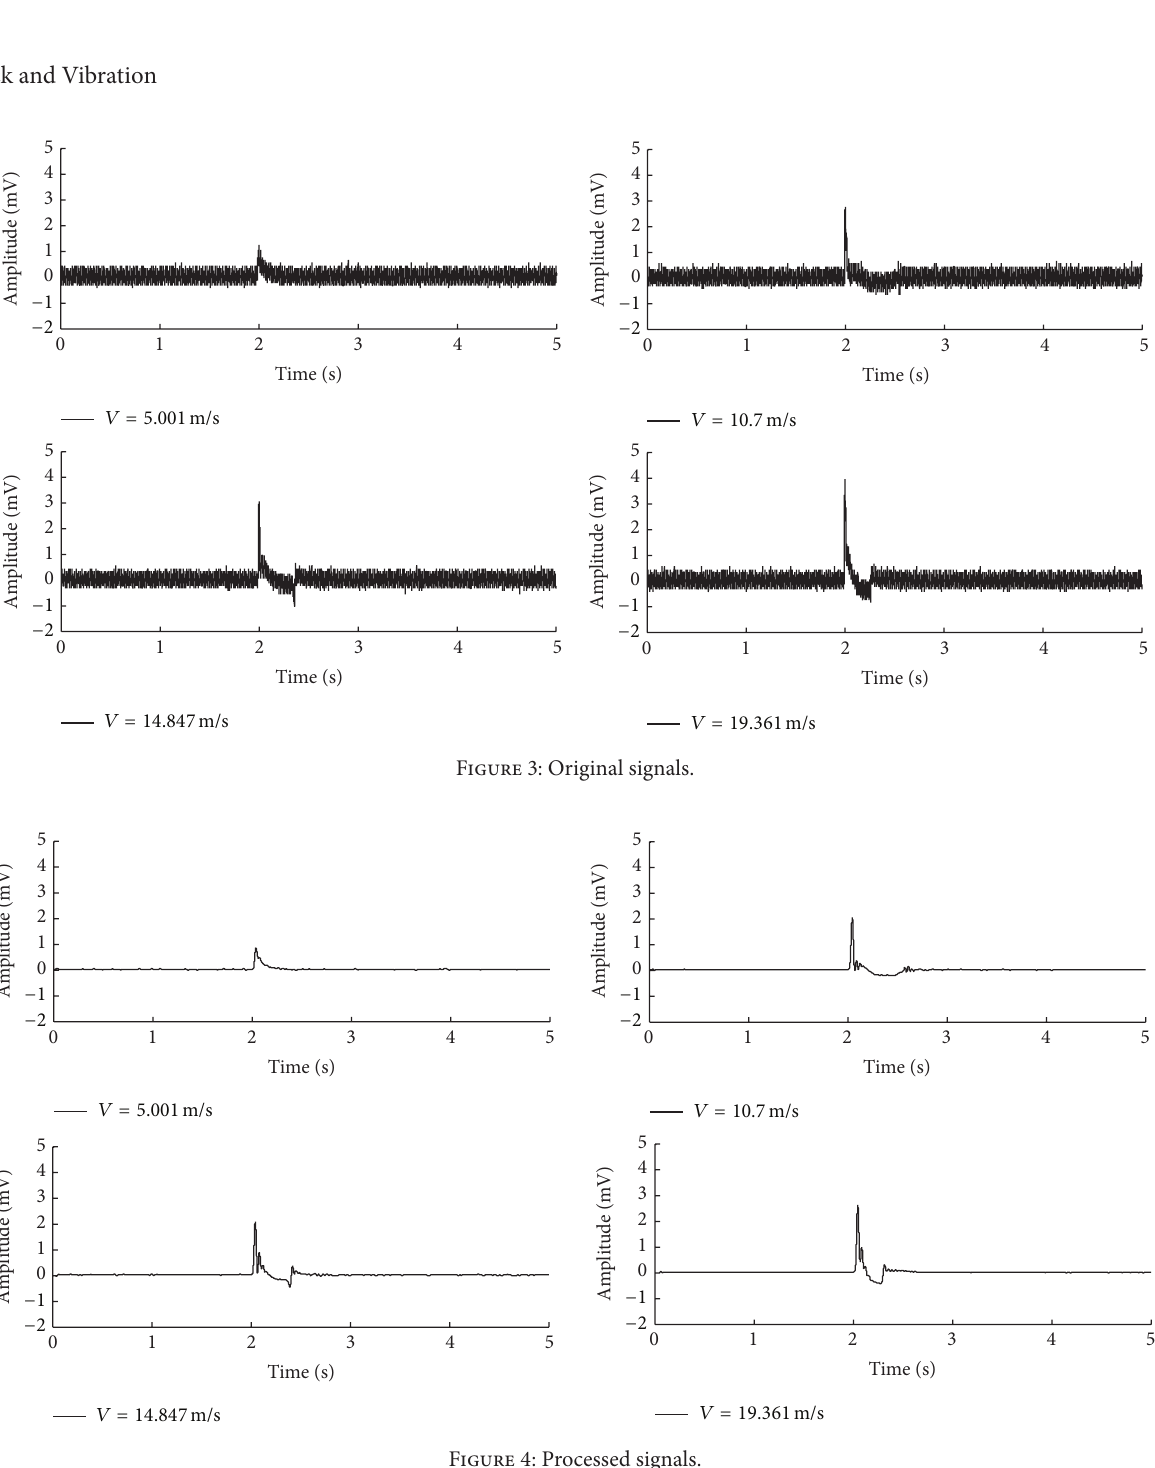
Figure 4: Processed